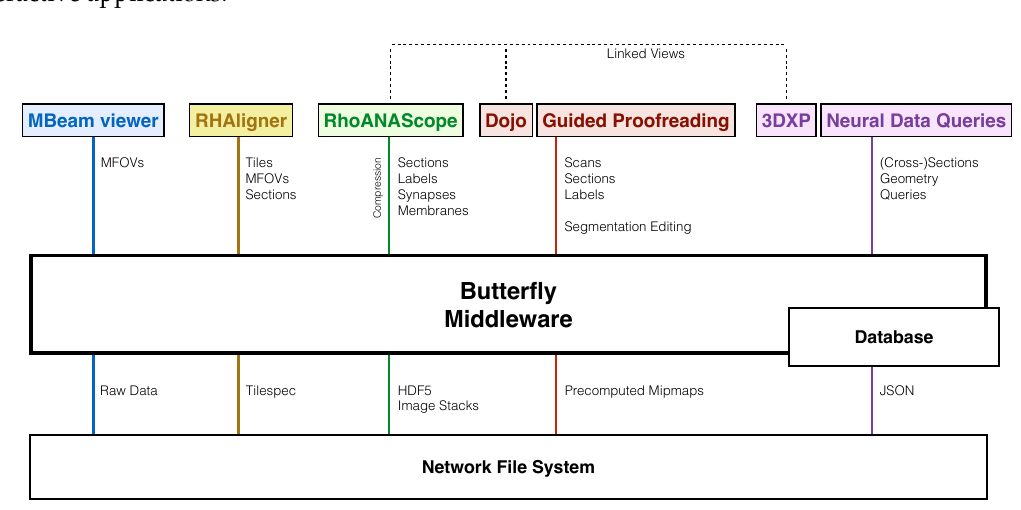
Figure 2. Our software system includes tools tailored to each stage of the connectomics pipeline, which requires exploring and interacting with data stored in different ways on a network file system (XFS storage): The MBeam viewer enables image quality assessment during image acquisition by rendering multi-beam-field-of-views (MFOVs) from raw microscope data. The RHAligner scripts allow for the monitoring and debugging of the alignment process by rendering the tilespec format which separates transformations and data. RhoANAScope visualizes sections and the corresponding neuron labels, synapse segmentations, and membrane probabilities during segmentation. Dojo and